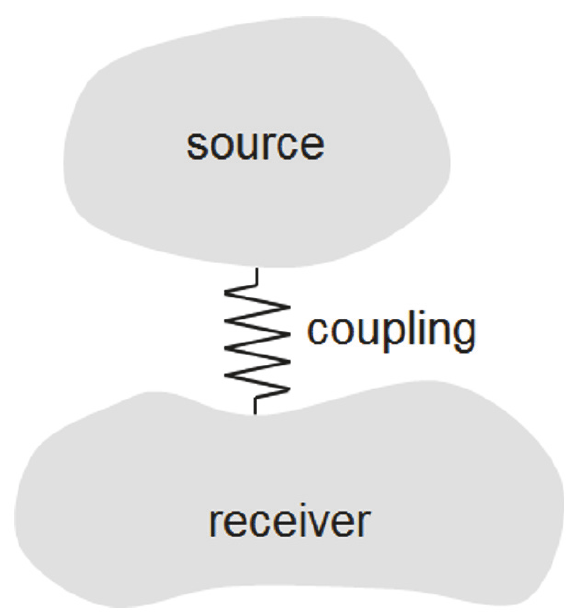
Figure 4: Coupling of two degrees of